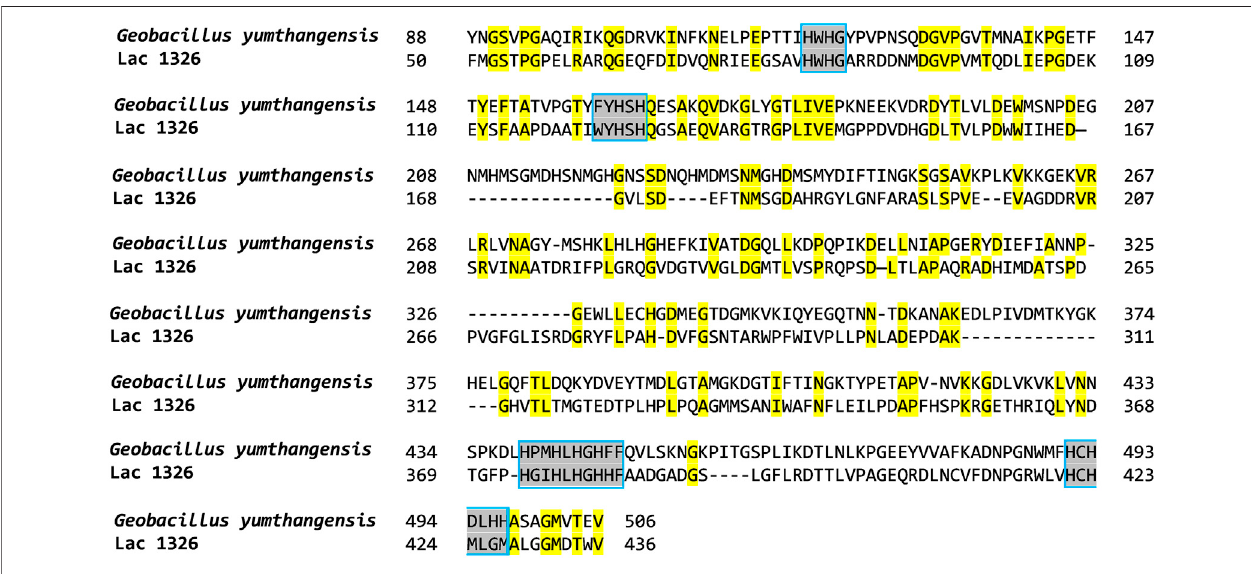
FIGURE 1 | Amino acid sequence alignment of pLac Gy and Lac1326. Conserved residues are highlighted in yellow. The four highly conserved amino acid sequences found in laccases are marked by a box and highlighted in grey.